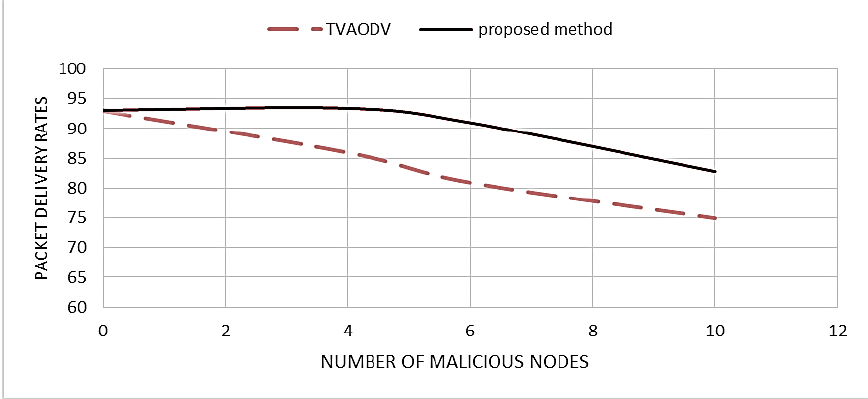
Figure 3. Packet delivery rate vs. number of malicious